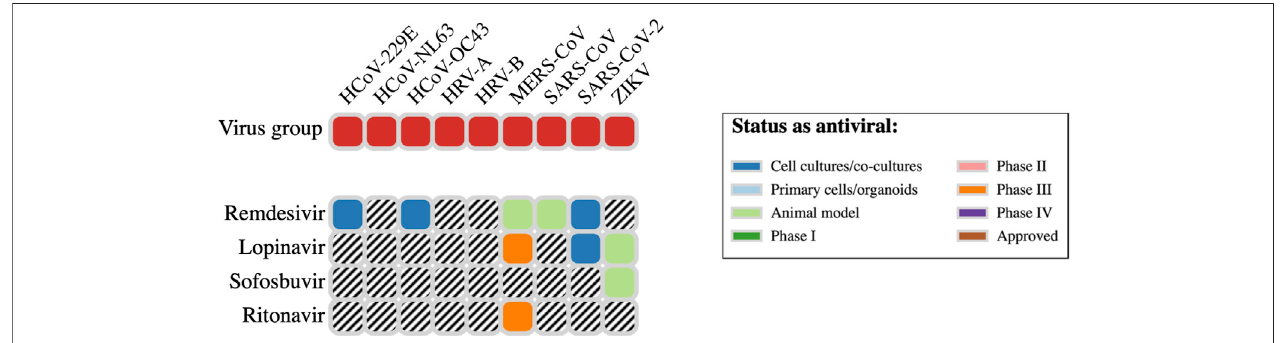
FIGURE 7 | Spectrum of antiviral activity and nature of assessment for four antiviral hit